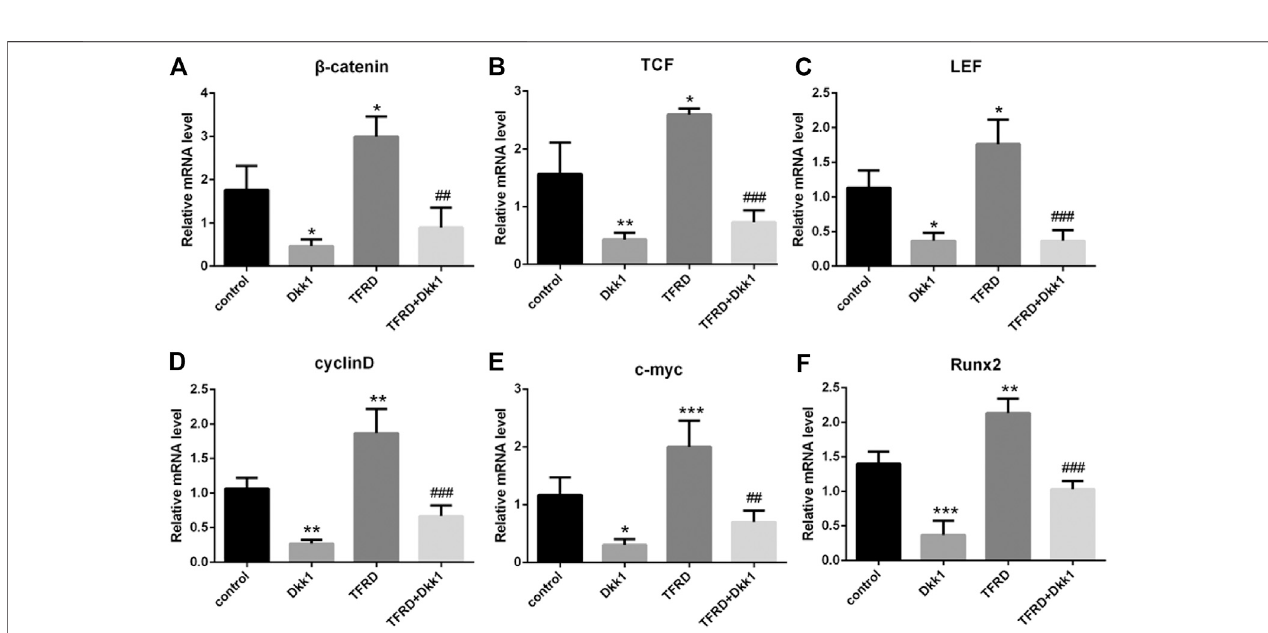
FIGURE 5 | Effect of TFRD on mRNA related to Wnt/ β -catenin signaling pathway in osteoblasts. (A – F) The relative mRNA levels of β -catenin, TCF, LEF, cyclinD, c-mycand Runx2weredetected byRT-PCR. N (cid:2) 3/group.Each valuewaspresentedasthemean ± SD. ***p < 0.001, **p < 0.01, *p < 0.05vs. thecontrol group; ### p < 0.001, ## p < 0.01 vs. the TFRD